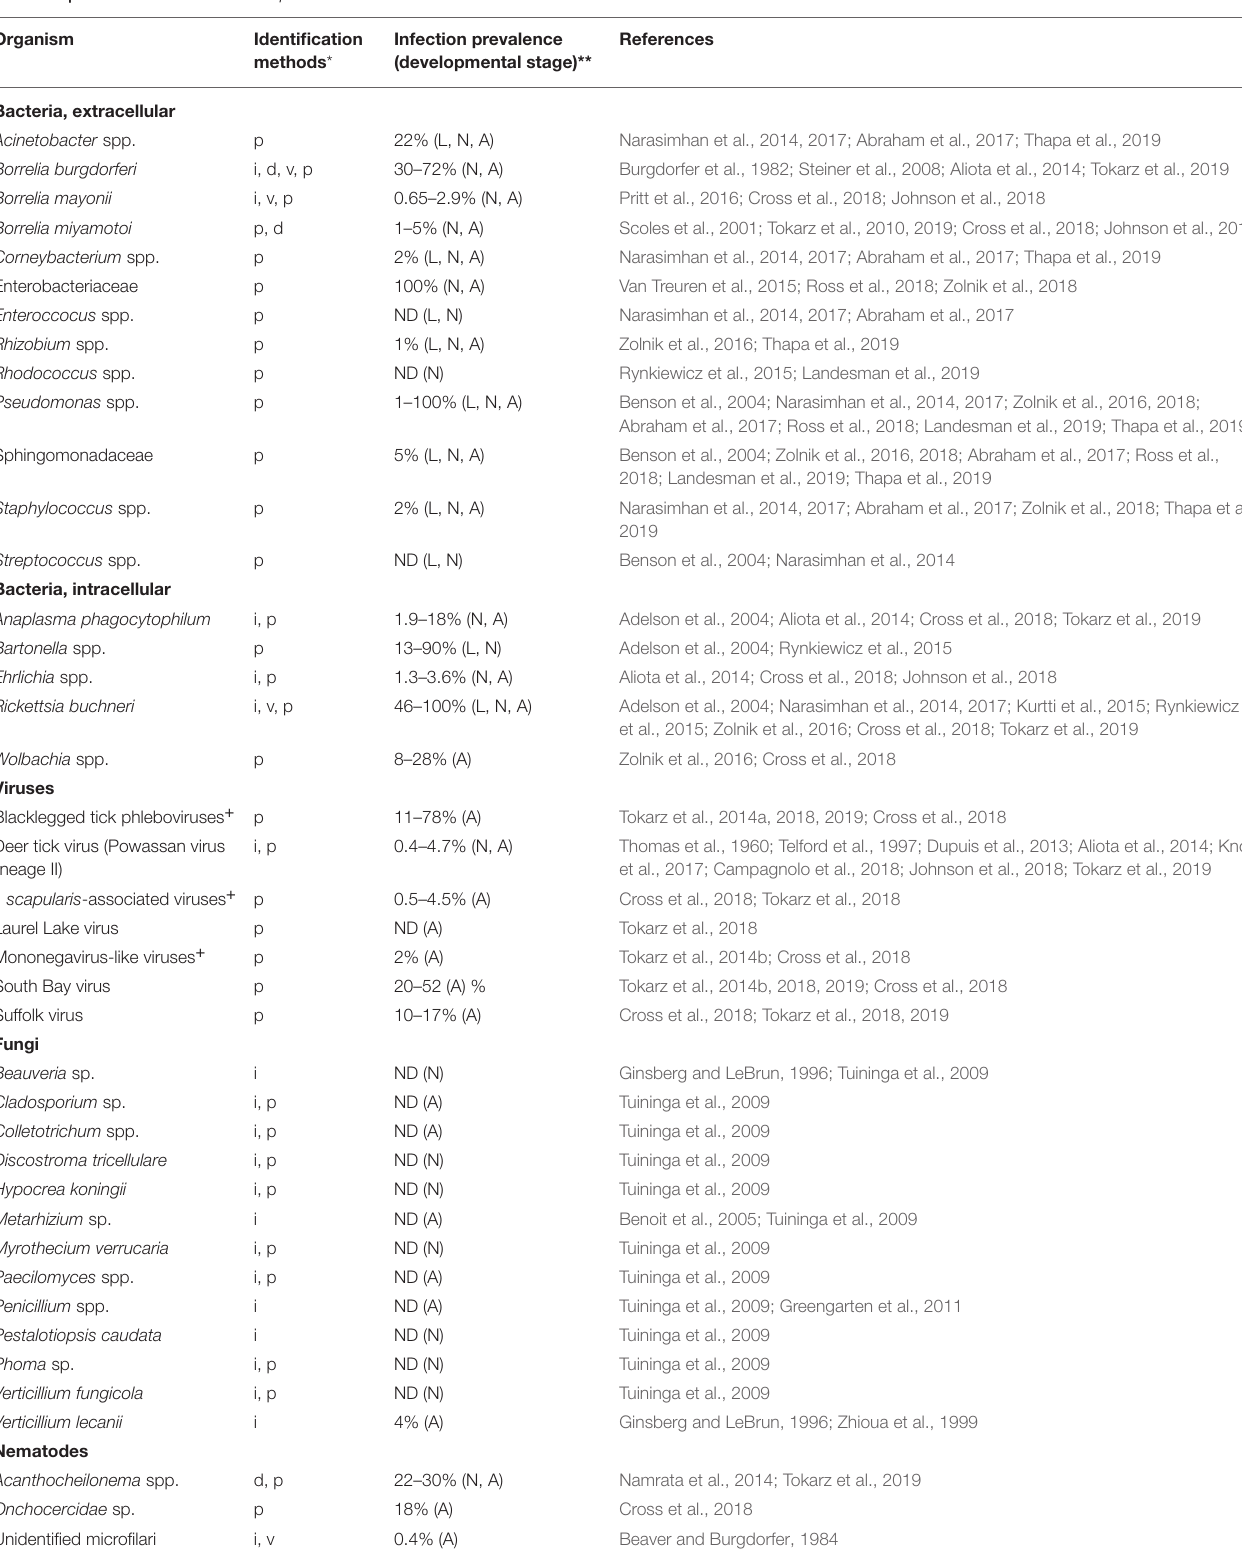
TABLE 1 | Microbes detected in I. scapularis